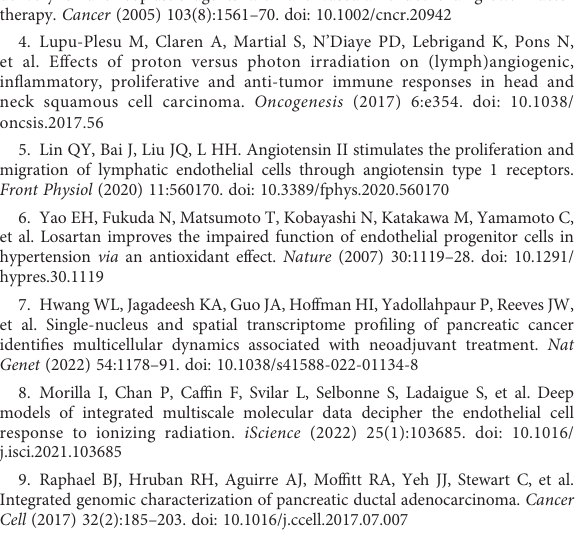
SUPPLEMENTARY FIGURE 2 (A) Proportion of endothelial nuclei assigned to each of the two state programs for all PDAC tumors ( n =37) strati fi ed by treatment status (left; untreated, n =18; CRT, n= 14; CRTL, n =5), radiation dose (middle; untreated, n =18; low-dose, n =11; high-dose, n =8), and radiation type (right; untreated, n =18; low-dose photons, n =7; low-dose protons, n =4). (B) Proportion of endothelial nuclei for each of the fi ve lineage programs from a subset of PDAC tumors with treated patients 13 and 14 removed (n =35) strati fi ed by treatment status (left; untreated, n =18; CRT, n= 12; CRTL, n =5), radiation dose (middle; untreated, n =18; low-dose, n =10; high-dose, n =7), and radiation type (right; untreated, n =18; low-dose photons, n =5; low-dose protons, n =4). *